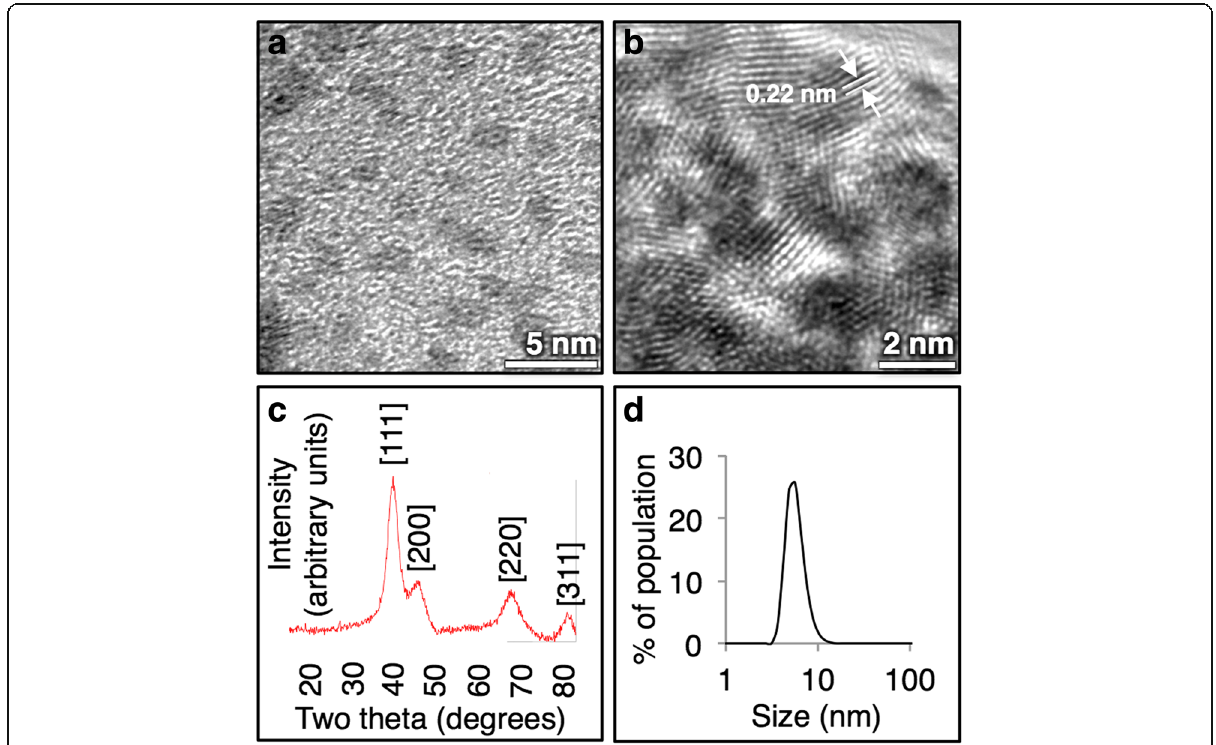
Fig. 1 a Iridium nanoparticles are 2 – 3 nm by TEM imaging, with b with a highly crystalline lattice parameter. c XRD spectrum matches elemental iridium, and d particles have a hydrodynamic size of 5 nm in water by DLS